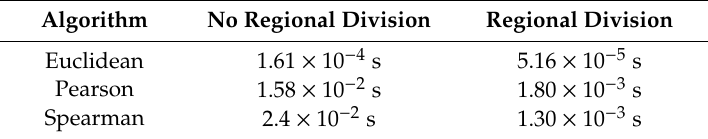
Table 7. Time statistics before and after regional division.